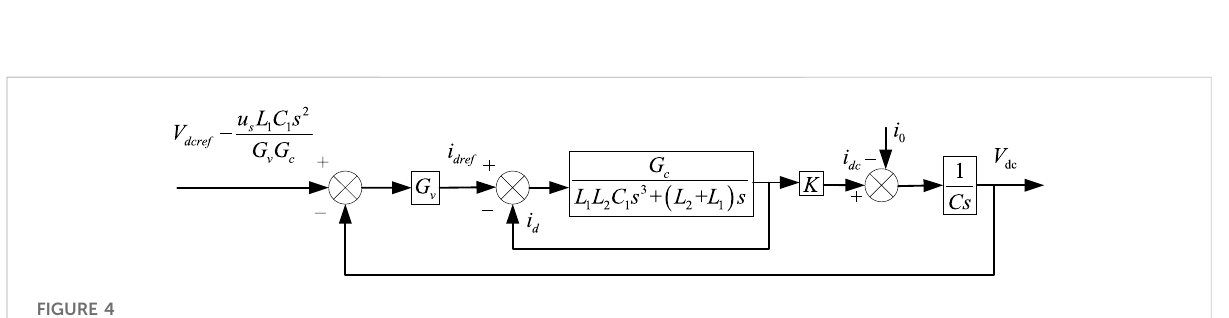
FIGURE 4 Simpli fi ed dual closed-loop control block diagram of the LCL